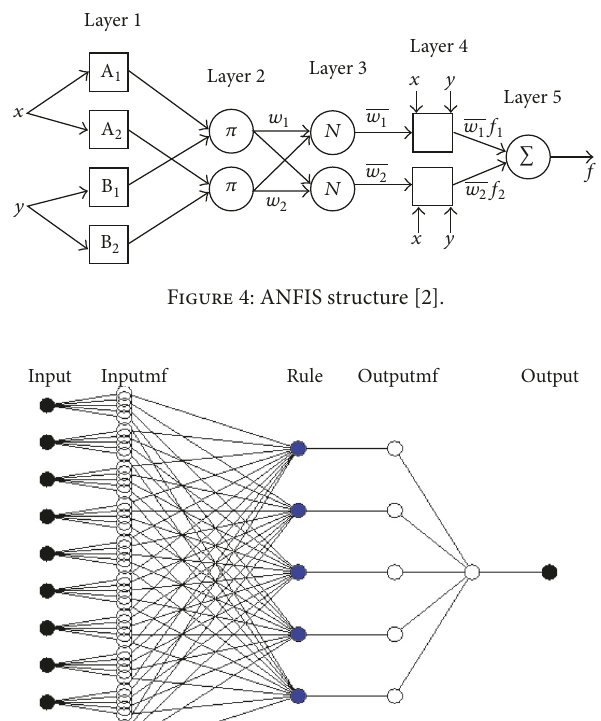
Table 3: Rules for zero yaw rate error derivative.